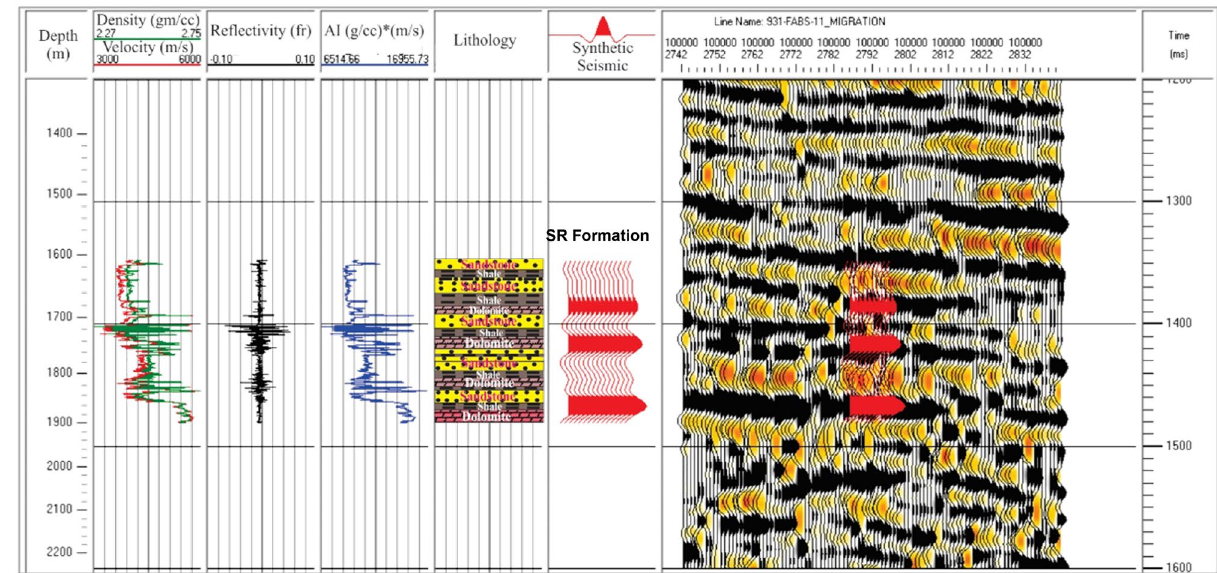
Figure 5. Synthetic seismogram (red traces) for the Bijnot-1 well (Salt Range Formation), showing from left to right: true vertical depth in meters, sonic velocity (µs/ft) and bulk density (g/cm 3 ) logs, reflectivity (reflection coefficient), acoustic impedance (AI), lithology, synthetic seismogram, traces from a part of seismic line FABS- 11, and two-way time in